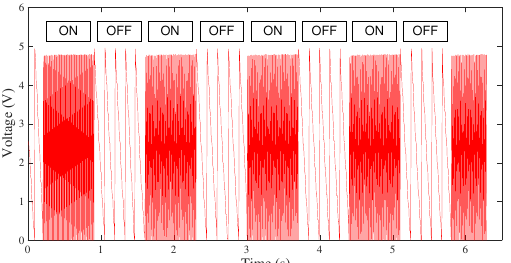
Figure 7. Red-to-red link, T = 700 ms.